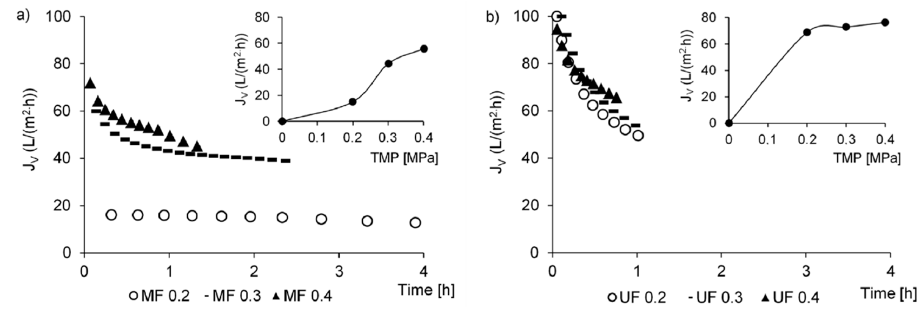
Figure 2. Changes in permeate flux in MF ( a ) and UF ( b ).